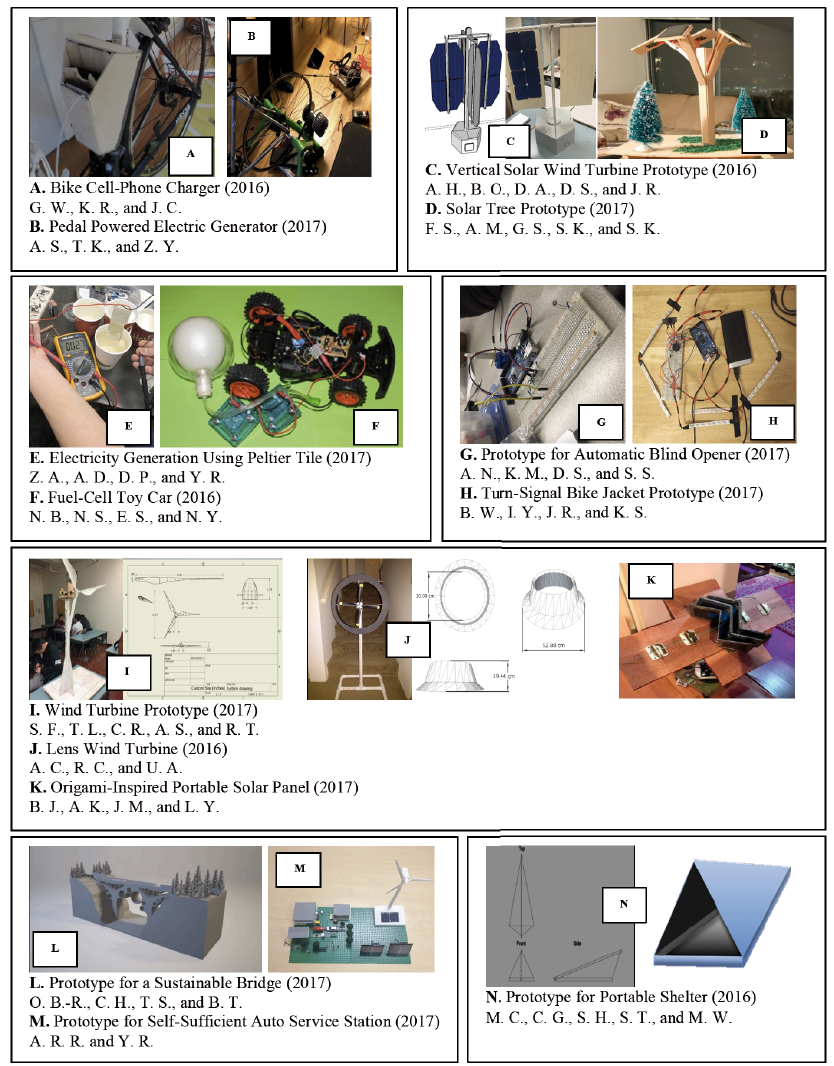
Fig. 5. APSC 1010 sample projects delivered in